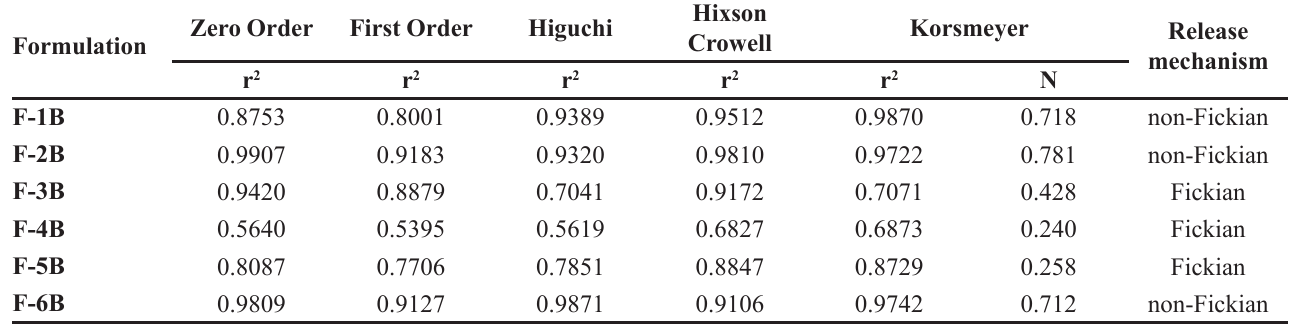
TABLE VI – For FTIR data interpretation